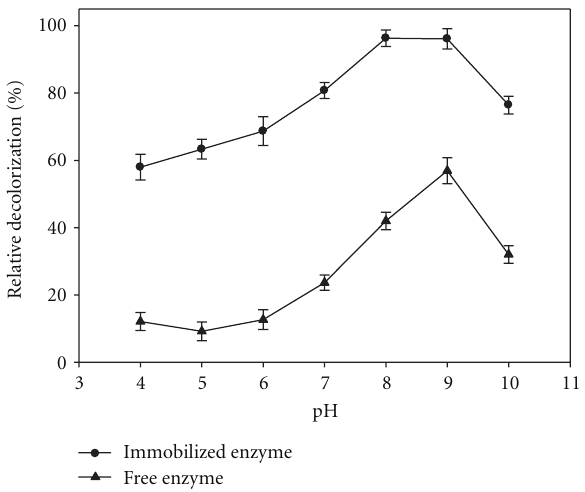
Figure 3: Influence of temperature on relative decolorization activity of free laccase ( (cid:2) ) and immobilized laccase ( • ). Data were mean values ± SD.